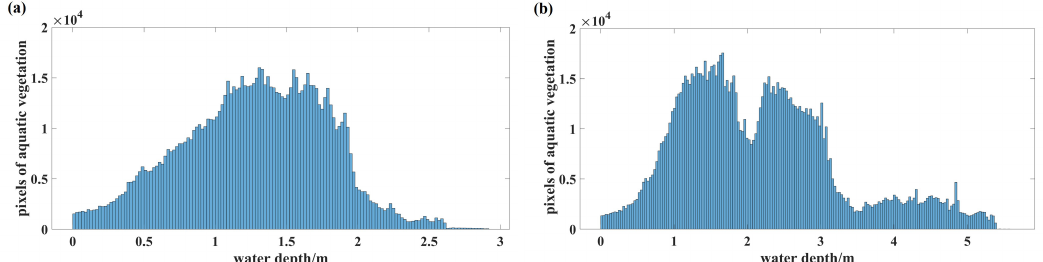
Figure 13. Water depth distribution for areas with aquatic vegetation in ( a ) Spring (average water depth in May) and ( b ) Summer (average water depth of June, July and August) for all